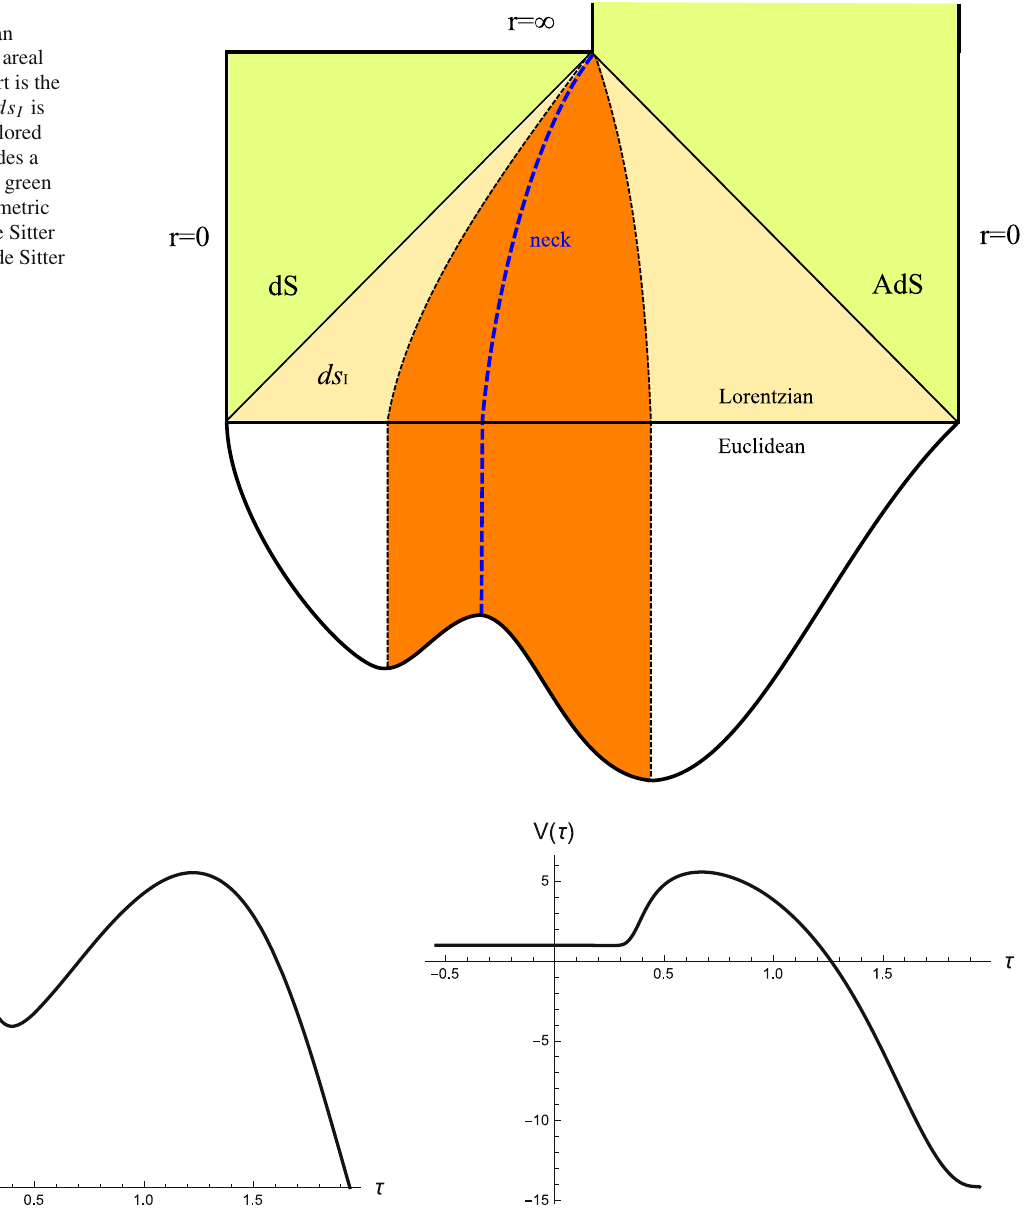
Fig. 5 a (τ) (left) and V (τ) (right) for (cid:19) = 0 .